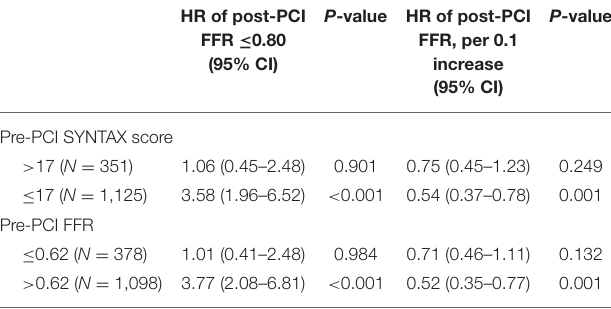
TABLE 3 | Differential implications of residual ischemia and post-PCI FFR on clinical outcomes according to the